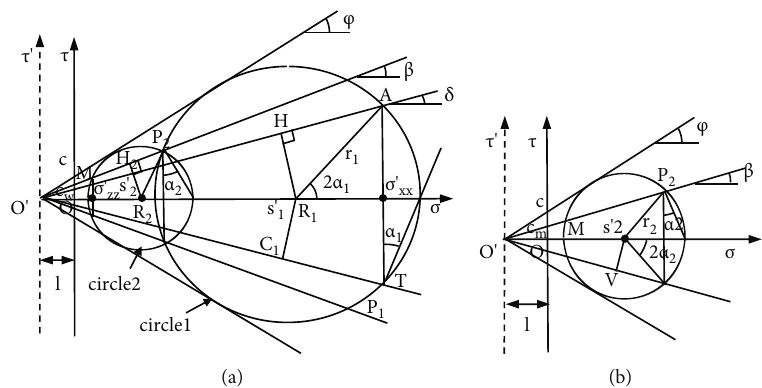
Figure 3: The passive earth pressure stress